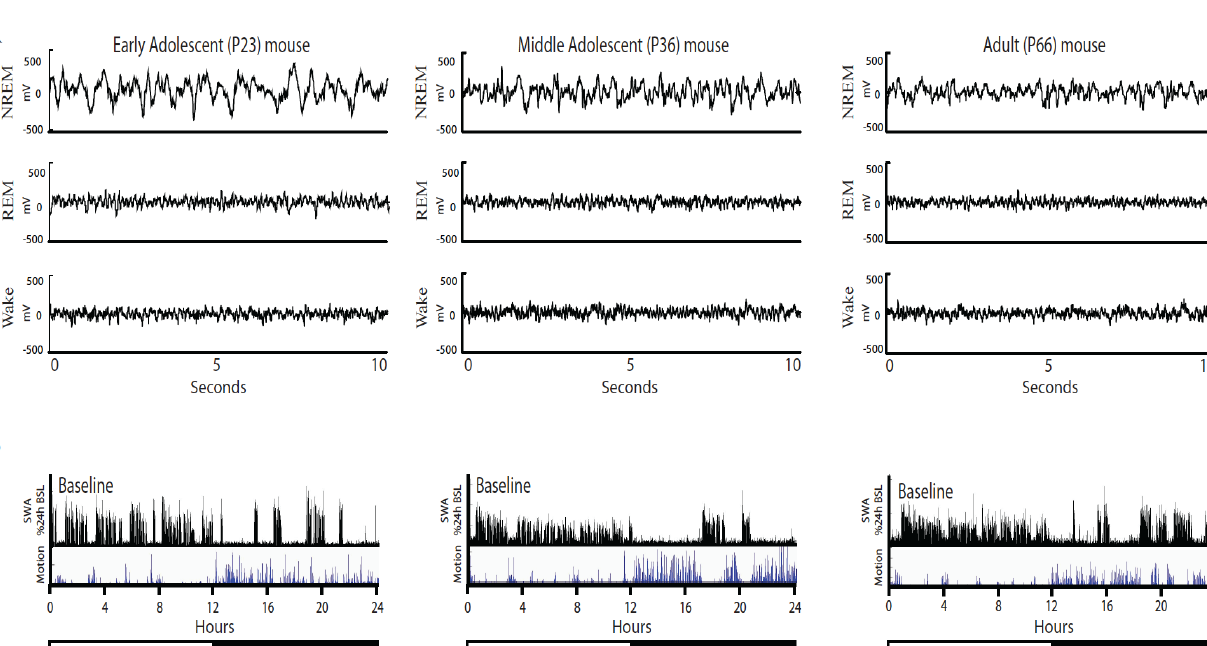
Figure 1. Representative examples of EEG traces in adolescent and adult mice. ( A ) EEG traces (10 s) for NREM sleep, REM sleep, and wake in an early adolescent (P23), middle adolescent (P36) and adult (P66) mouse are shown. ( B ) The bottom panels show the time course of NREM slow wave activity (SWA, expressed as % of 24-h mean SWA, 4-s epochs) and locomotor activity (video-based motion detection, 4-s epochs) for the same animals during 24 h of baseline. Motion is measured in arbitrary units and values cannot be compared across